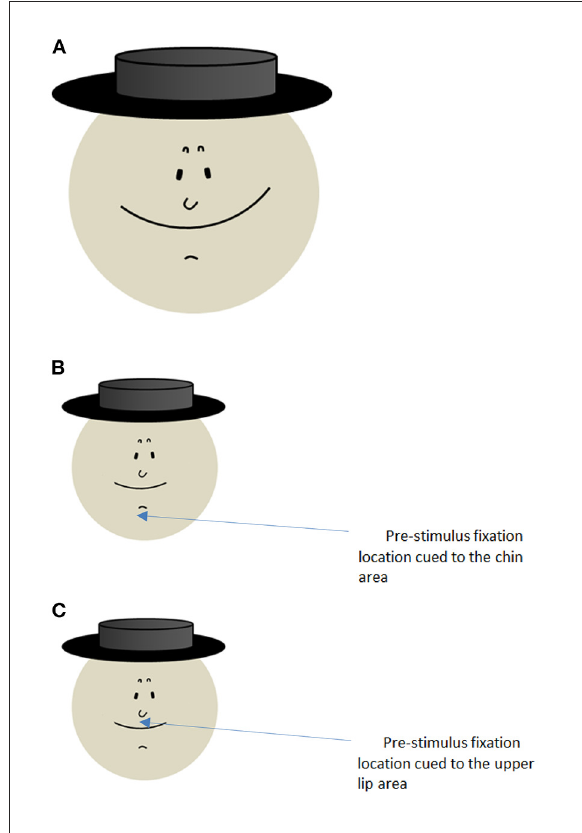
FIGURE1 Examples of schematic facial images allowing for ambiguity in facial expression perception. (A) Merry-or-Worry image adapted from Bachmann (2022); (B,C) depict faces with subdued conspicuity of the facial element below the nose, shown in an informal study where pre-stimulus fixation location of the gaze was varied in order to direct perceptual